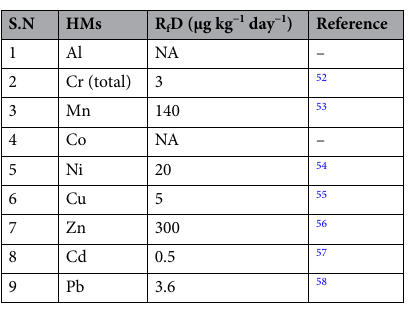
Table 4. Reference dose (R f D) for different HMs. NA not available.